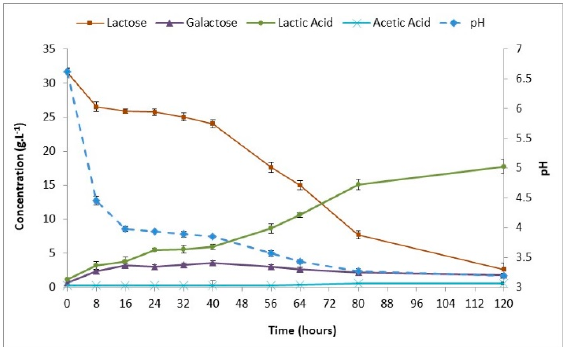
Figure 1. Metabolite profile of whey during fermentation by mesophilic starter bacteria. Results reflect the average of three independent trials ± standard deviation.